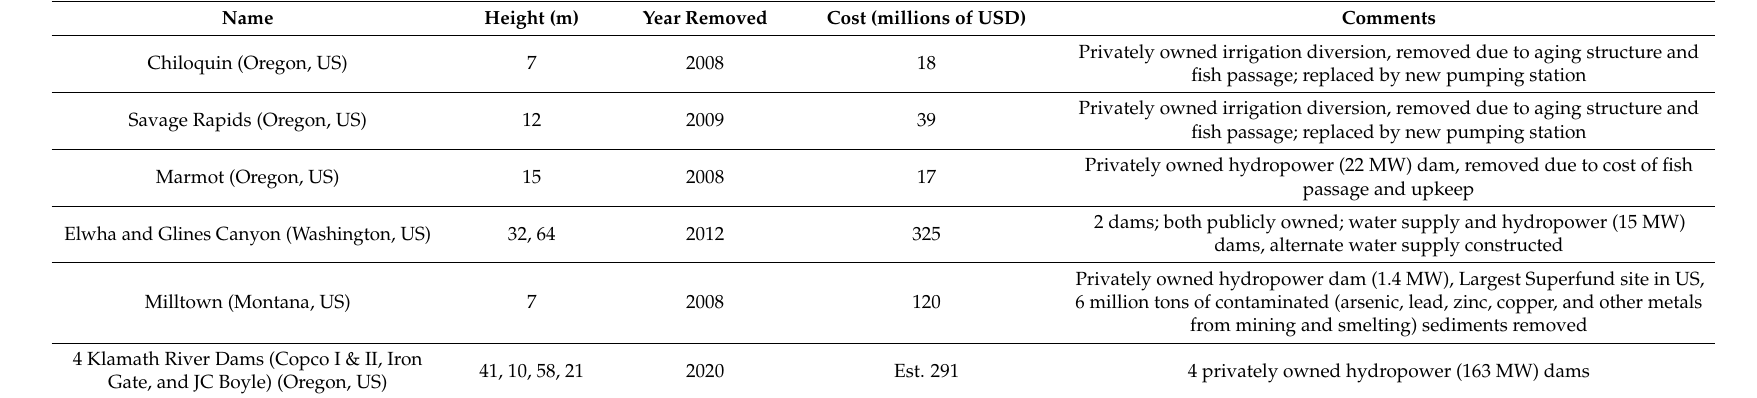
Table 6. Dam decommissioning costs